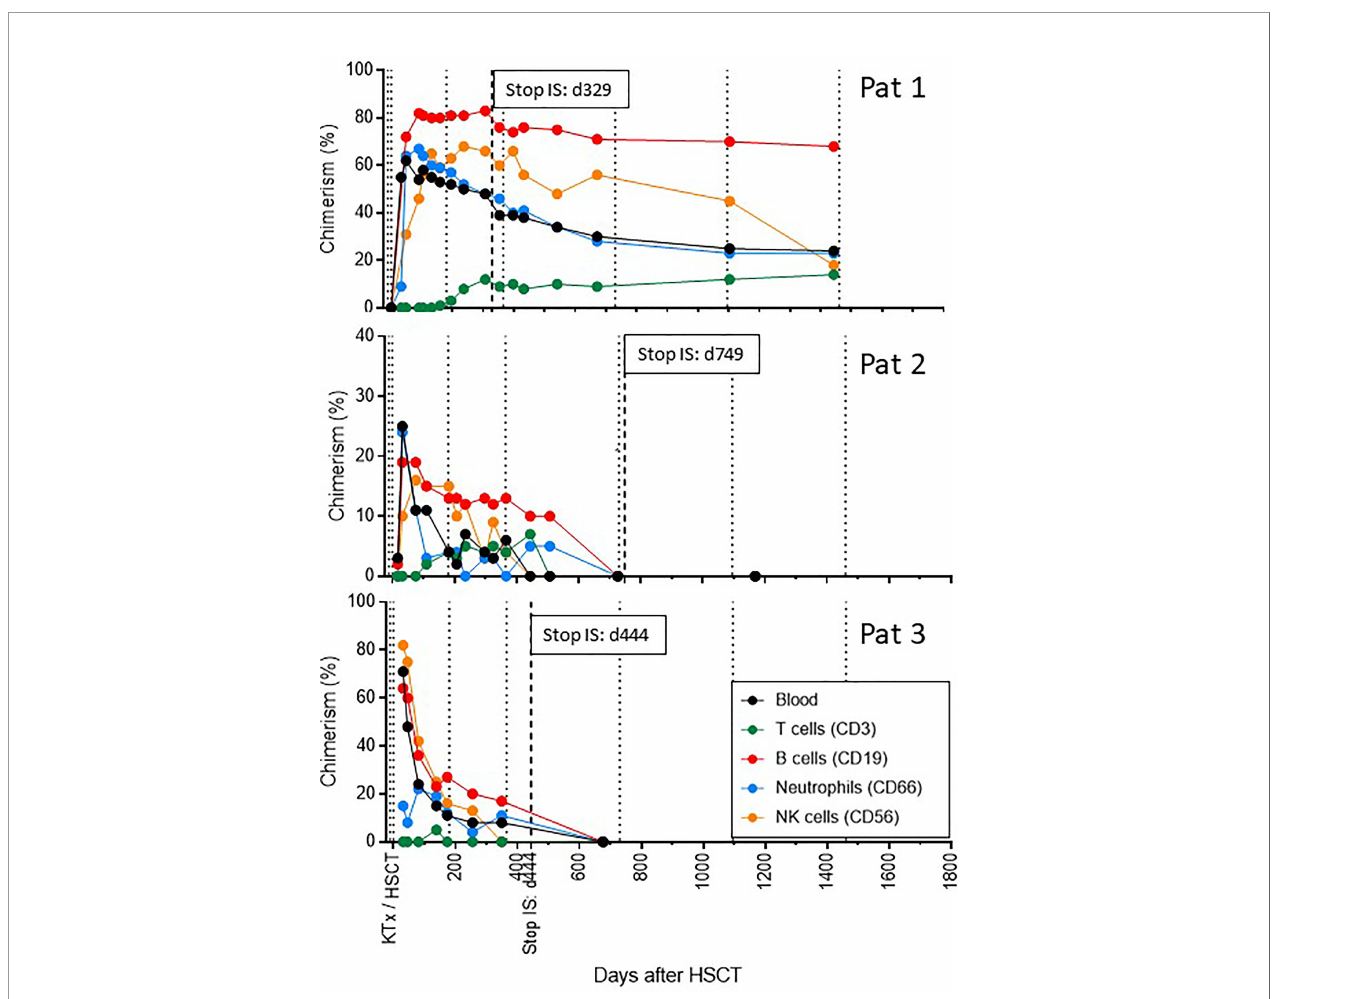
FIGURE 6 | Synopsis of donor chimerism over time. The level of whole blood as well as lineage-speci fi c donor chimerism is shown over time for all three recipients. Dotted lines indicate time intervals of 6 and 12 months post-transplant and yearly thereafter. The hatched line indicates the time point of stop of all immunosuppressive treatment